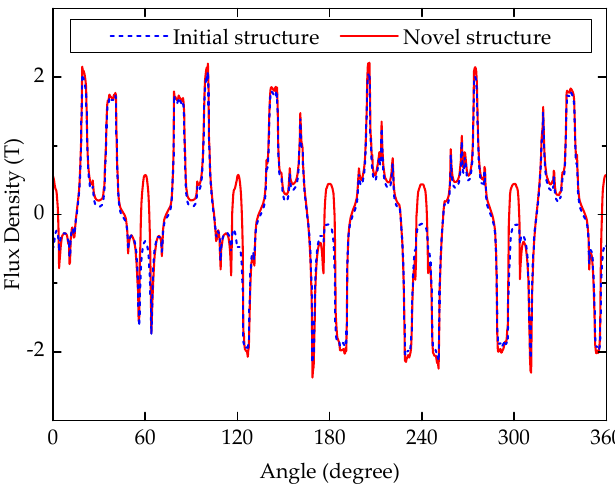
Figure 5. No ‐ load air ‐ gap flux density distributions for the two FSPM machines. Figure 5. No-load air-gap flux density distributions for the two FSPM machines.